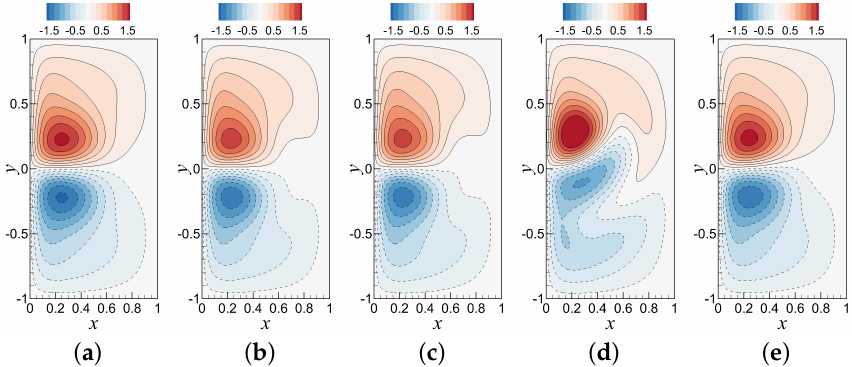
Figure 5. Mean stream function contour plots between t = 15 and t = 60 obtained by reference FOM and standard ROM-GP simulations for Re = 25: ( a ) ψ FOM at a resolution of 128 × 256; ( b ) ψ ROM-GP with R = 10 modes; ( c ) ψ ROM-GP with R = 20 modes; ( d ) ψ ROM-GP with R = 30 modes; and ( e ) ψ ROM-GP with R = 40 modes. Note that a stable and well-estimated solution can be found using R = 10 modes and adding more modes might yield worse solutions due to a possible over-fitting as occurred in R = 30 case.